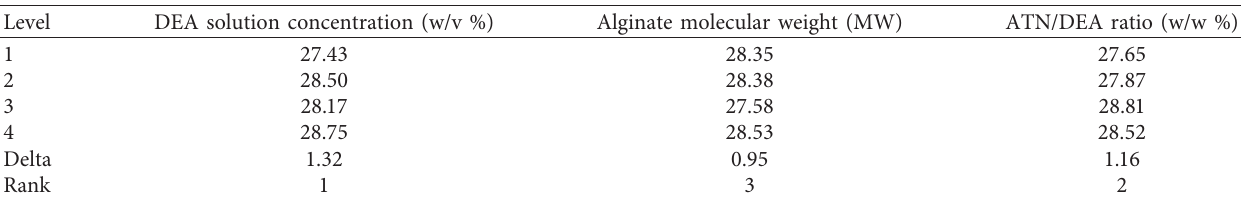
Table 7: Signal-to-noise ratio of zeta potential responses with respect to process parameters and their levels, the larger the better.